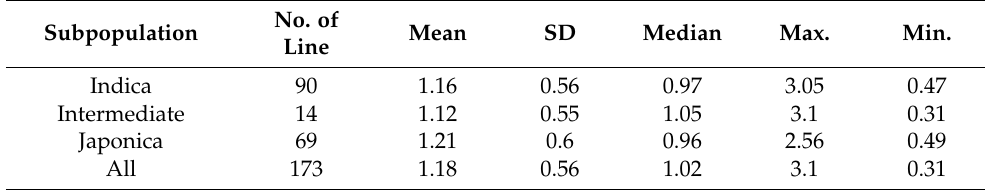
Table 1. Phenotypic variation of NPQ values in different groups. No. of Subpopulation